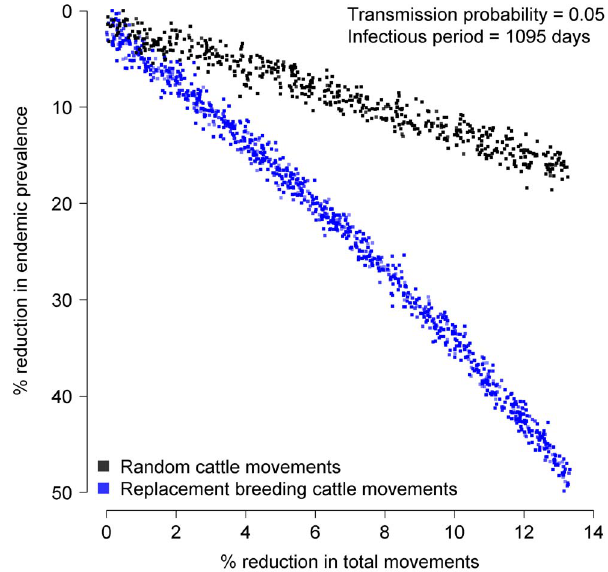
Figure 2. Estimated reduction in the number of purchased replacement breeding cattle with improved herd management. The horizontal bars show the percentage reduction in the total number of replacement breeding cattle purchased by the study herds when the values for age at first calving, calving interval, and calf mortality variables, the target value were set as the top quintiles and the values for culling rates were set at the middle quintile in the ZINB models. Each variable was tested alone and in combination.